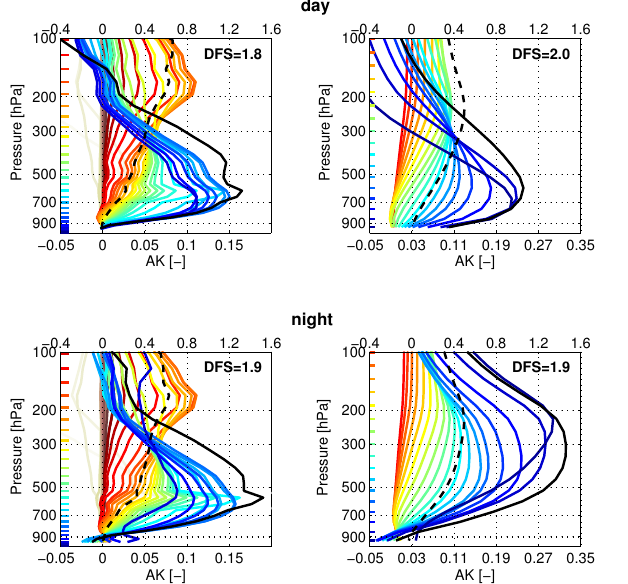
Fig. 3. As Fig. 2 for Windhoek (22.6 ◦ S, 17.1 ◦ E) on 24 Jan- uary 2008. Windhoek lies at an altitude ∼ 1700m hence the lower cut-off of the averaging